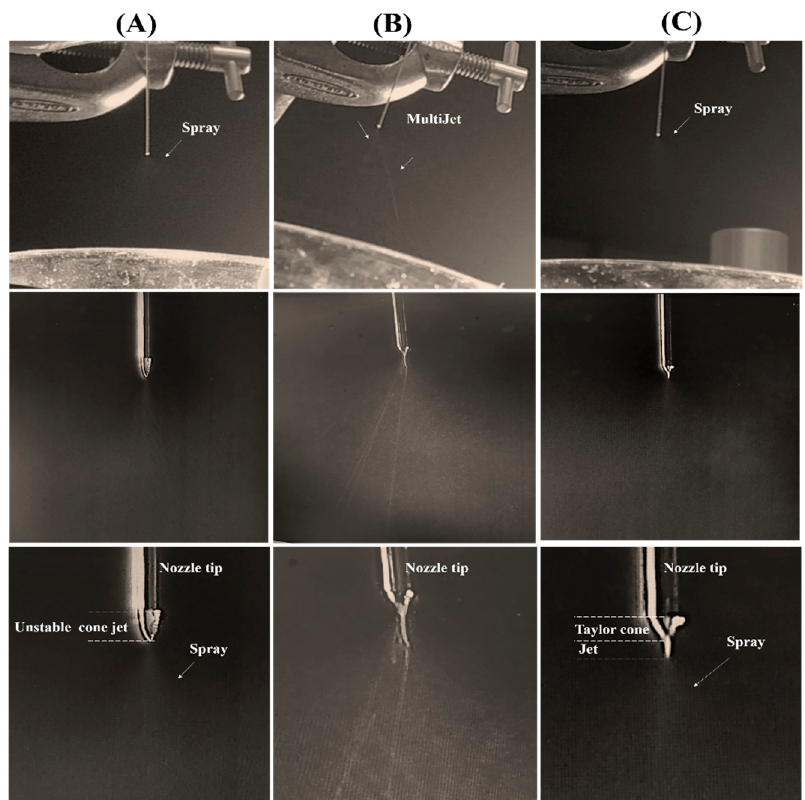
Figure 3. Camera image showing the spray mode by different ALG solutions: ( A ) unstable cone jet from S1, ( B ) unstable multijet from S3, and ( C ) stable cone jet from S8. Process parameters were nozzle tip: 30 G, flow rate: 0.1 mL/h, applied voltage: 9.5 kV, distance between tip and collector: 4 cm.